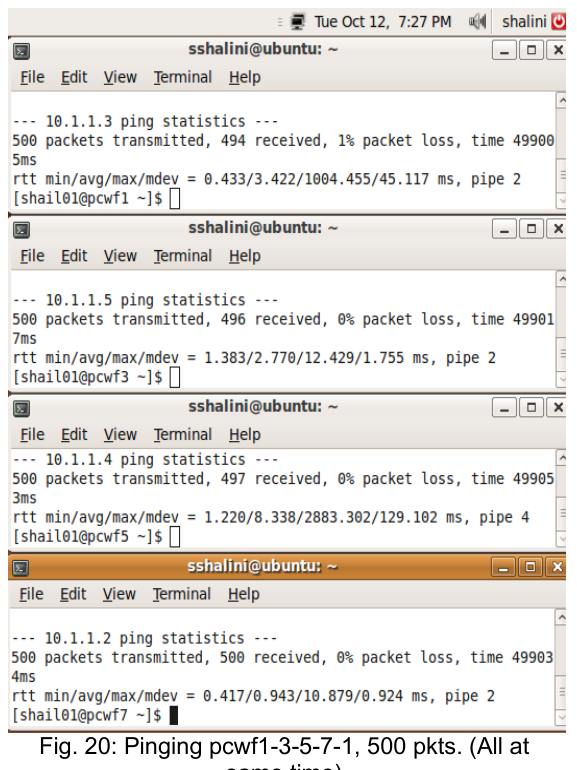
Fig. 20: Pinging pcwf1-3-5-7-1, 500 pkts. (All at same time)